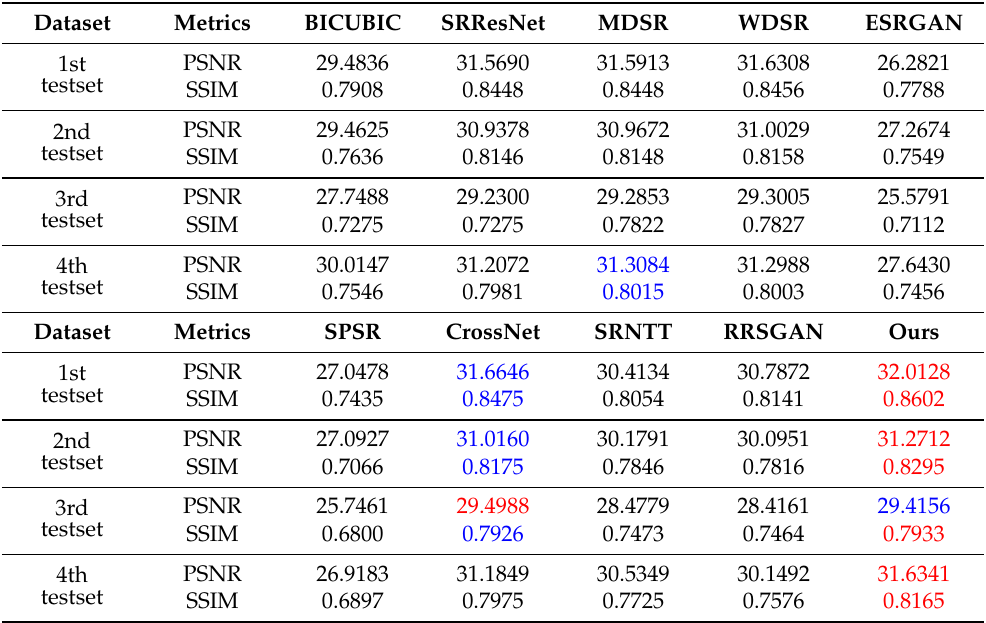
Table 3. Average PSNR and SSIM results of various SR methods of ×4 factor on the four test sets. Red index denotes the best performance. Blue index suggests suboptimal performance. The results of these comparison methods originate from [30].